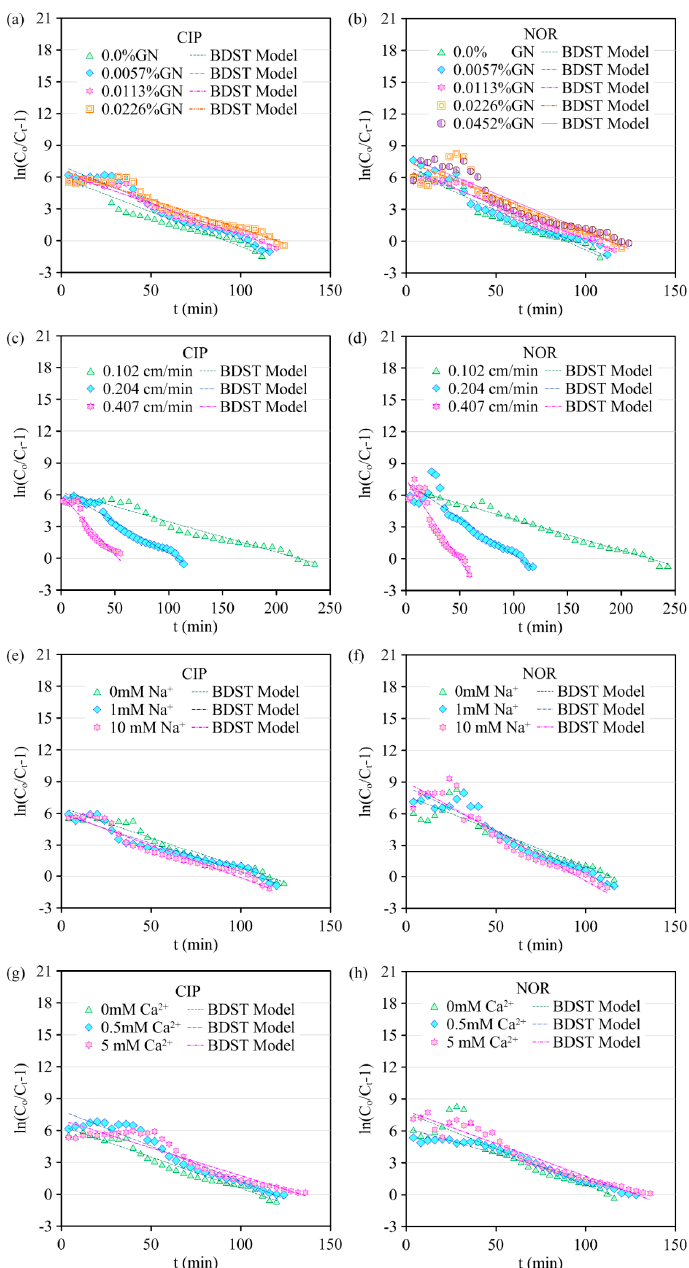
Figure 6. The results obtained by BDST model: ( a ) the change of ln(cid:4672) (cid:3004) (cid:3116) C 0 − 1 with time and simulated (cid:3004) (cid:3295) C t results of BDST for CIP migration under different mass fractions of GN packed in column; ( b ) the change of with time and simulated results of BDST for NOR migration under different mass fractions (cid:16) (cid:17) C 0 − 1 of GN packed in column; ( c ) the change of ln with time and simulated results of BDST for C t (cid:16) (cid:17) C 0 − 1 CIP migration under different flow velocities; ( d ) the change of ln with time and simulated C t (cid:17) (cid:16) C 0 − 1 results of BDST for NOR migration under different flow velocities; ( e ) the change of ln with C t time and simulated results of BDST for CIP migration under different ionic strengths (Na + ); ( f ) the (cid:16) (cid:17) C 0 − 1 change of ln with time and simulated results of BDST for NOR migration under different C t (cid:16) (cid:17) C 0 − 1 ionic strengths (Na + ); ( g ) the change of ln with time and simulated results of BDST for C t (cid:16) (cid:17) C 0 − 1 CIP migration under different ionic strengths (Ca 2+ ); ( h ) the change of ln with time and C t simulated results of BDST for NOR migration under different ionic strengths (Ca 2+